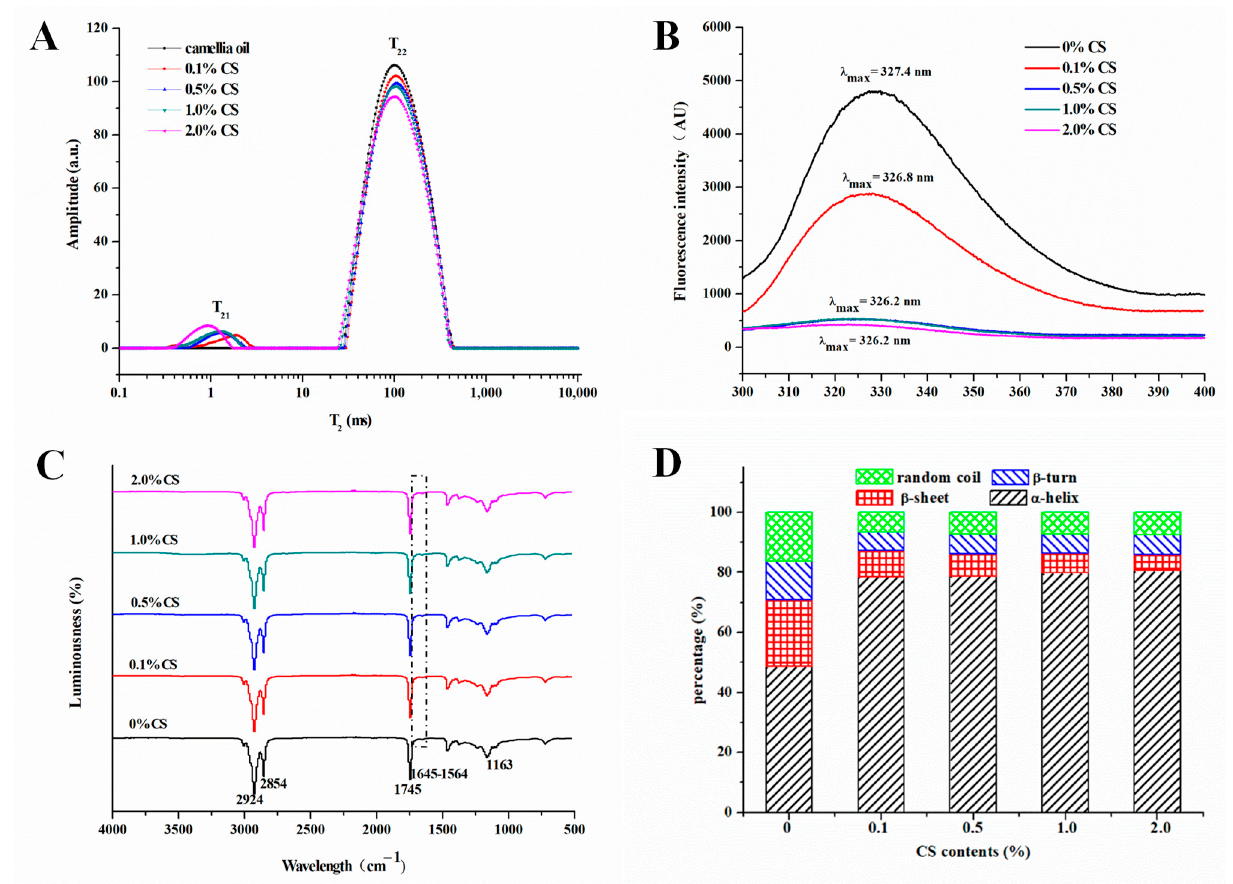
Figure 7. Distribution of transverse relaxation time spectra ( A ), Front-face fluorescence spectra ( B ),